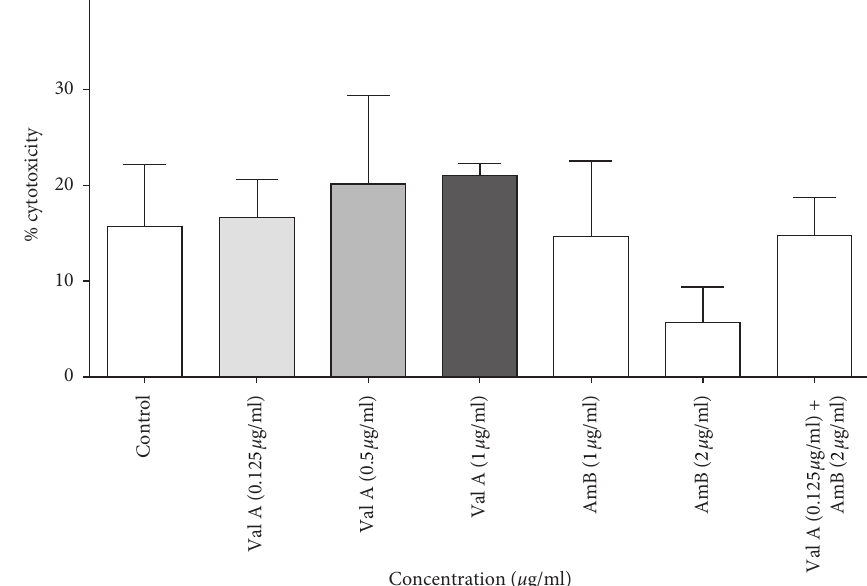
Figure 5: Validamycin A and the combination of validamycin A and amphotericin B have no cytotoxic effect on human bronchial epithelial cells. The cytotoxicity test was performed to observe the toxicity of validamycin A and amphotericin B on BEAS-2B cells using Lactate Dehydrogenase (LDH) Cytotoxicity Colorimetric Assay Kit II. Cell cultures were incubated at 37 ° C in a humidified environment containing 95% air and 5% CO 2 . After 24 hours, LDH reaction mixture was added (25 μ l) and incubated at 37 ° C for 30 minutes. Then, ODs were measured at 450nm using a spectrophotometer. Data are presented as means ± SE from three biological replicates. No significant difference was observed (one-way ANOVA with post hoc Bonferroni’s